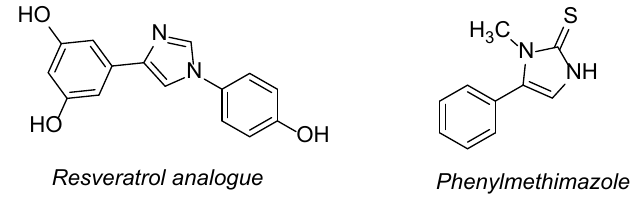
Figure 1. Imidazole molecules. Therefore, based on recent studies, benzenesulfonamide-bearing imidazole derivatives were synthesized in this work. Two cancer cell lines, namely TNBC cell line MDA-MB-231 and human melanoma cell line IGR39 were selected to test cytotoxic activity and compound effect on cell colony-forming ability. Both cancer types are considered very aggressive and have a low survival prognosis. Resistance to drugs occurs quite often in the case of melanoma treatment with targeted therapeutics, due to BRAF mutations [15]. More than half of patients with TNBC at an early stage have a recurrence of the disease, and about 40% of them die within the first 5 years [16]. We decided to explore synthesized compounds in clonogenic assay, which shows a single cell ability to grow into a colony [17] and mimics the cell ability to survive and proliferate after chemotherapy. We also tested novel compound effect on cancer cell spheroid (three-dimensional cultures) growth, as this model much better represents the real spatial connections between cells found in real tumor,